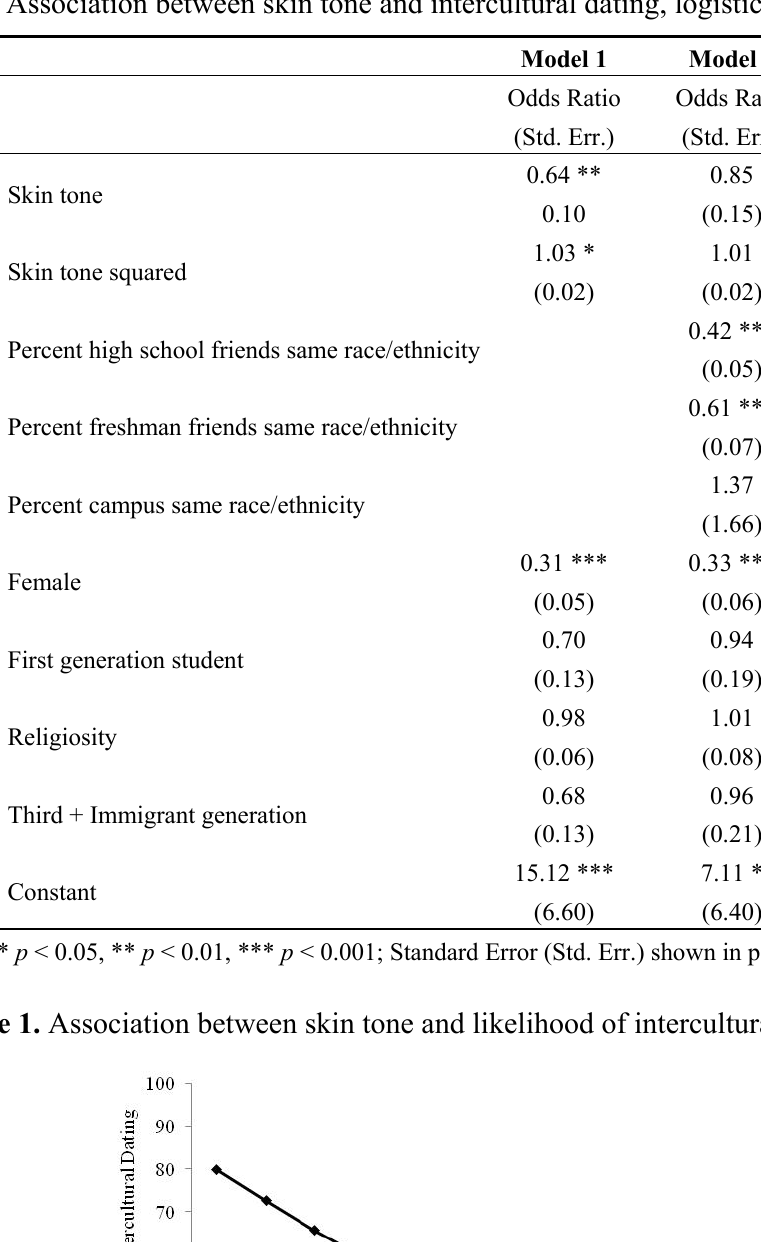
Table 4. Association between skin tone and intercultural dating, logistic regression.